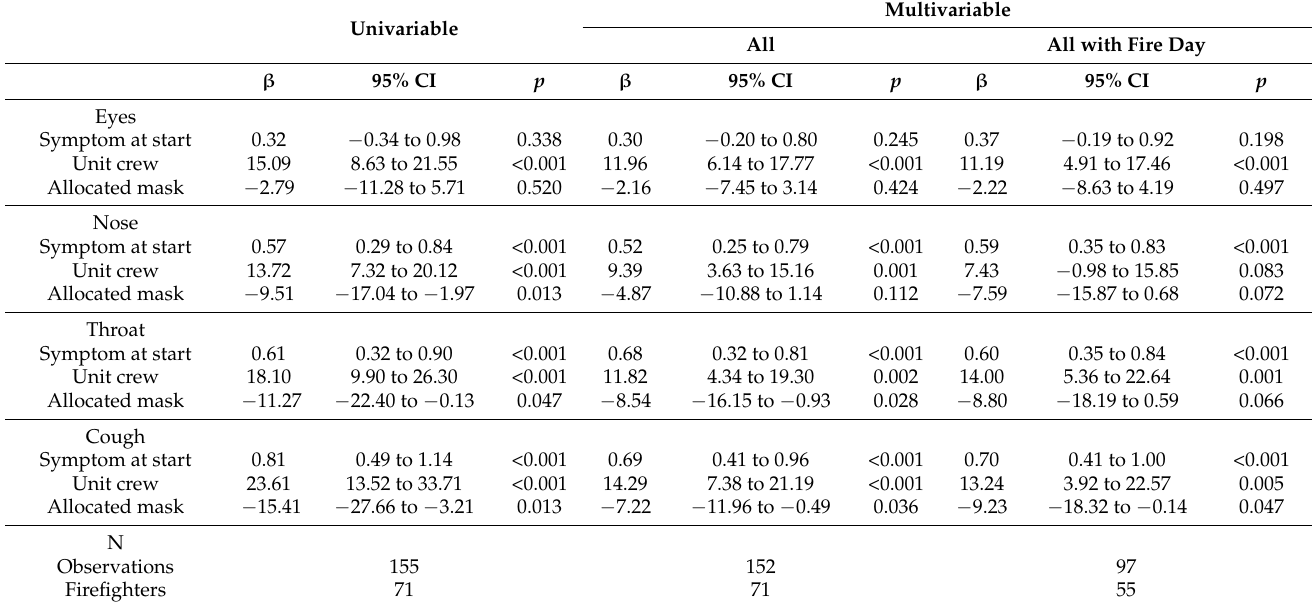
Table 4. Relation of end of rotation symptoms to start of rotation symptoms, crew type, and allocated N95. Linear mixed effects model.